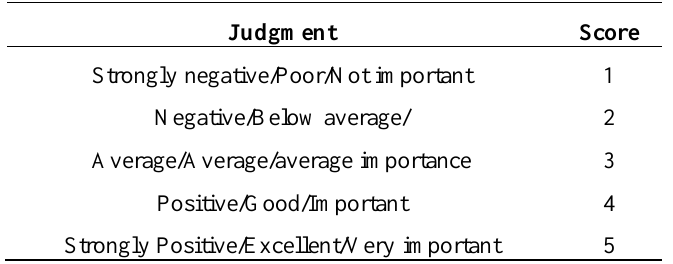
Table 2. The scoring system for the practices evaluation.